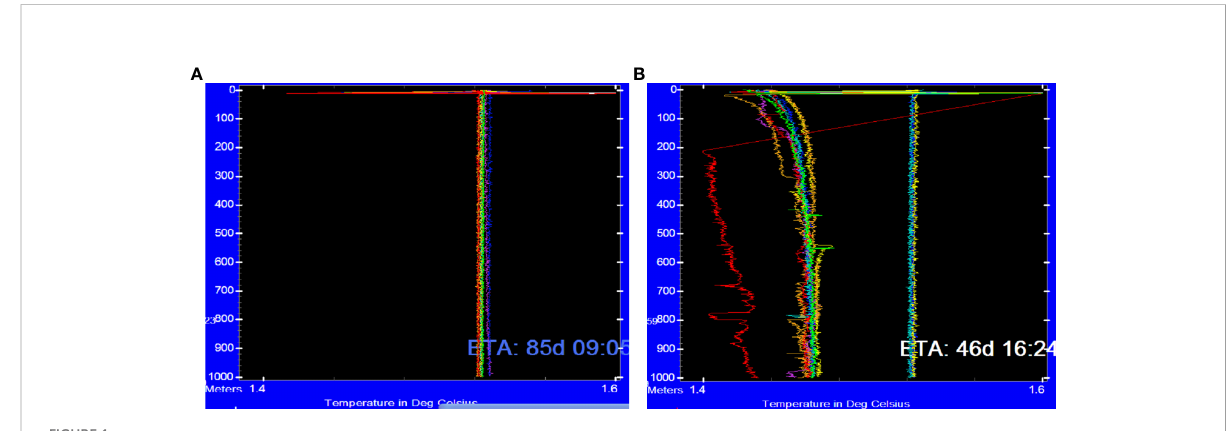
FIGURE 1 XBT Test Data at Expanded Scale. (A) Normal Data (B) Abnormal